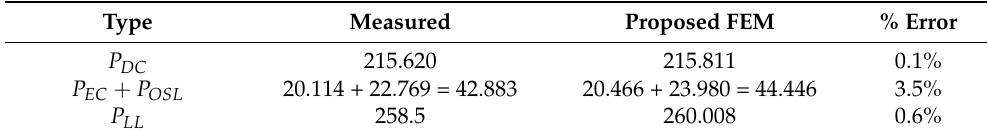
Table 4. Measured rated losses (kW)—Case